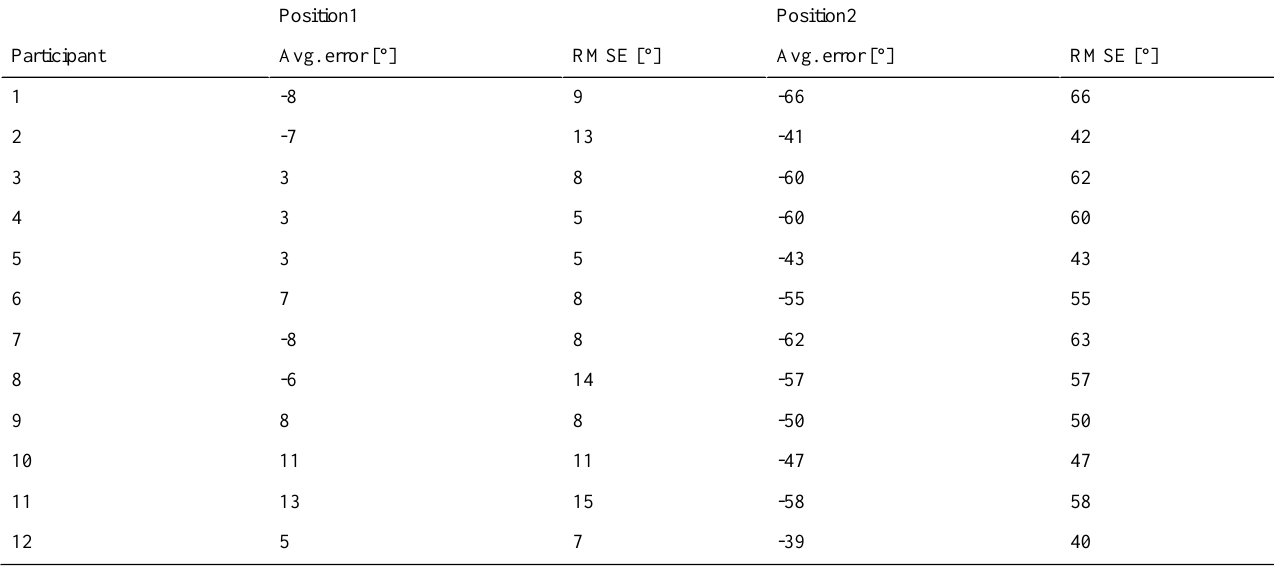
Table 3. Statistical results aggregated per participant for the orientation estimation method using AOE algorithm (Method1) with two sensor attachment positions.